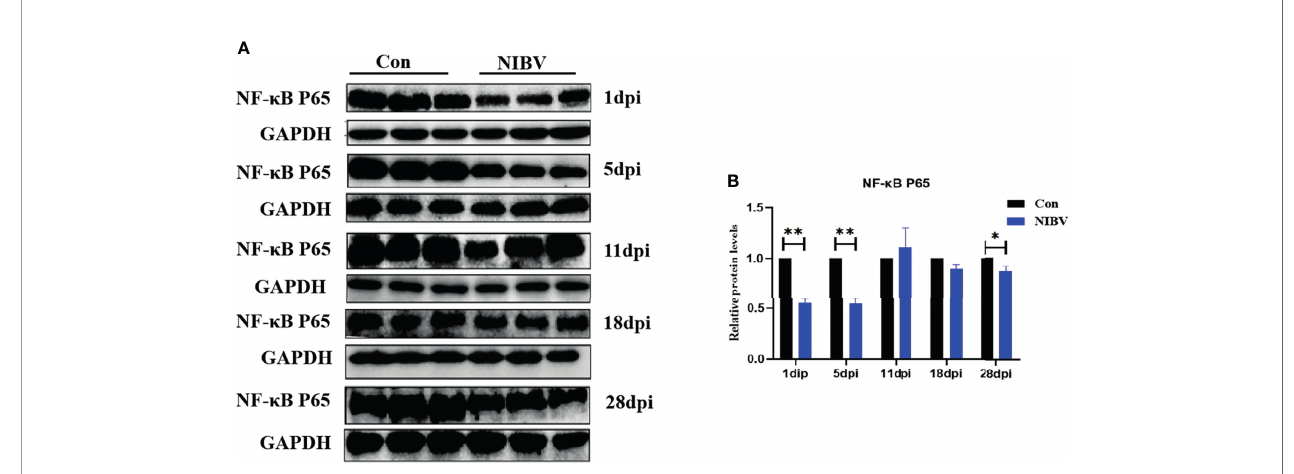
FIGURE 4 | (A) NF- k B P65 Protein band graph; (B) NF- k B P65 protein expression levels. *(0.01 < P < 0.05), **(P <